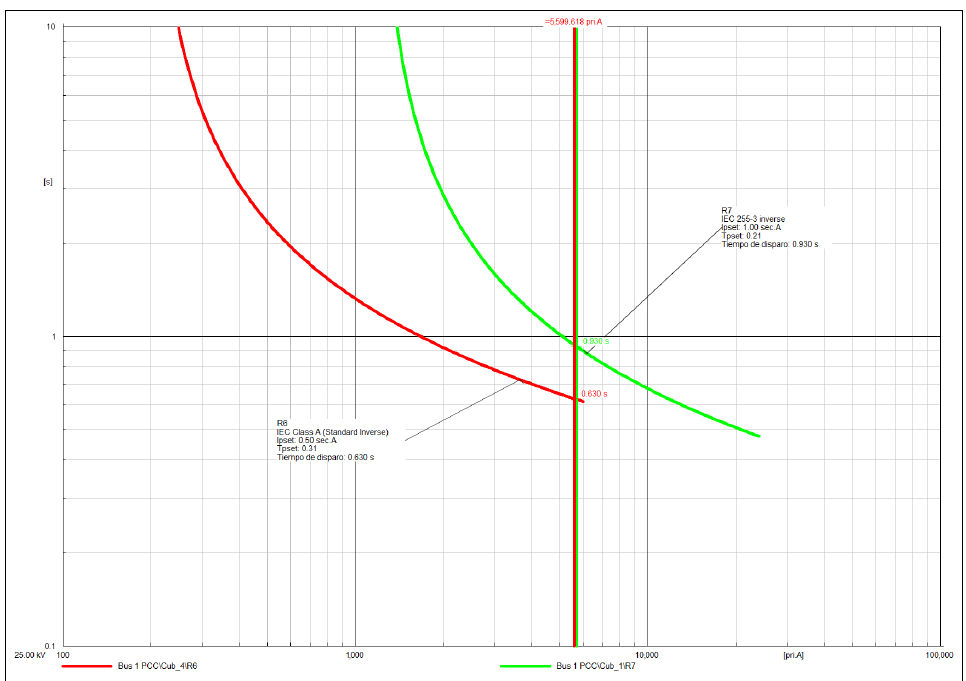
Figure 12. Coordination curve R7–R6 line fault DL-3 scenario